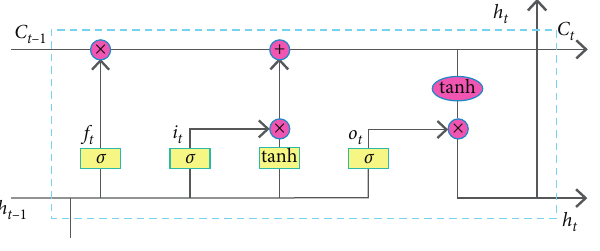
Figure 3: Model of LSTM.